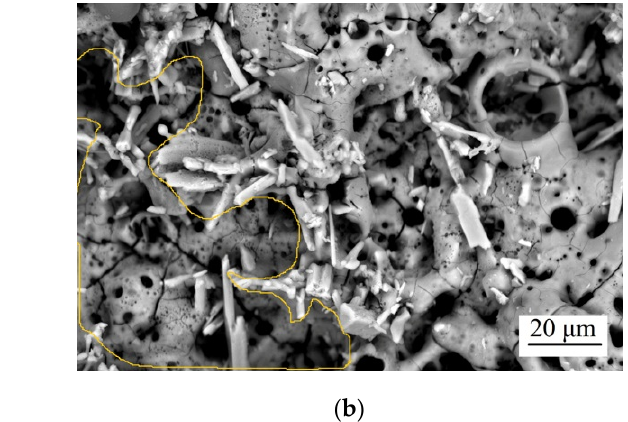
Figure 10. Graphs of the mass loss over time ( a ); optical images of the bare Mg0.8Ca alloy ( b – d ) and of the W-coating deposited at the voltage 500 V ( e – g ); ( b , e )—initial samples, ( c , f )—after 7-day dissolution, ( d , g )—after 16-day dissolution in 0.9% NaCl.